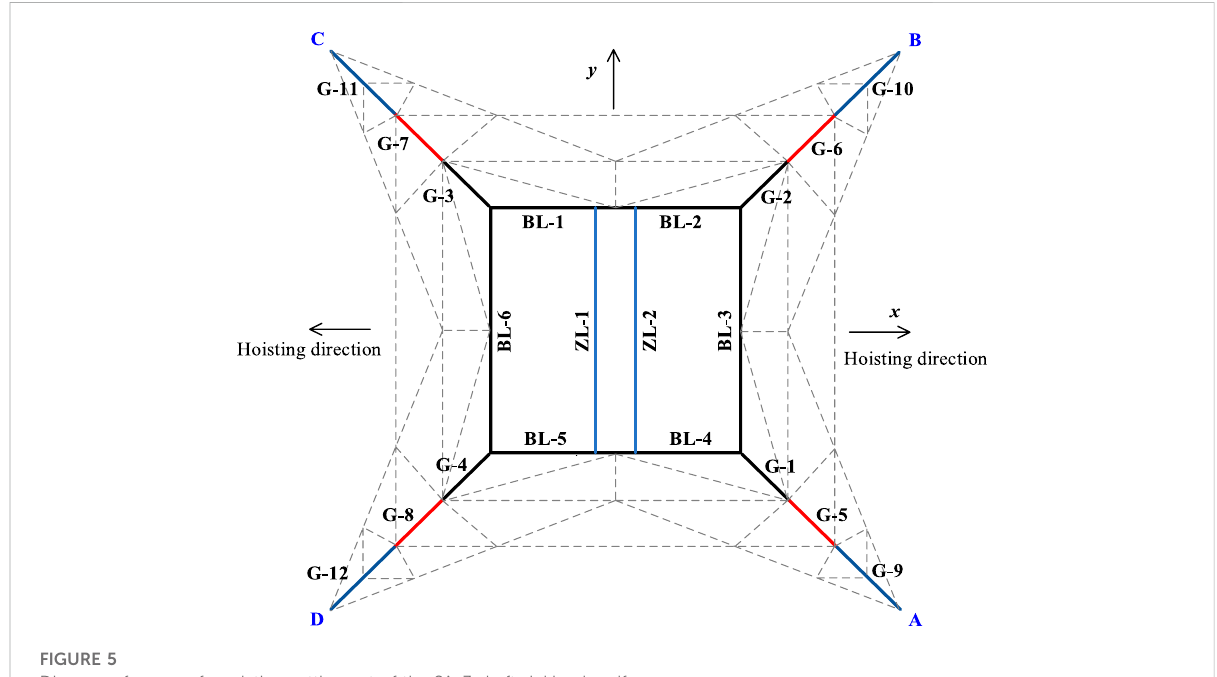
FIGURE 5 Diagram of uneven foundation settlement of the SA-3 shaft sinking headframe.